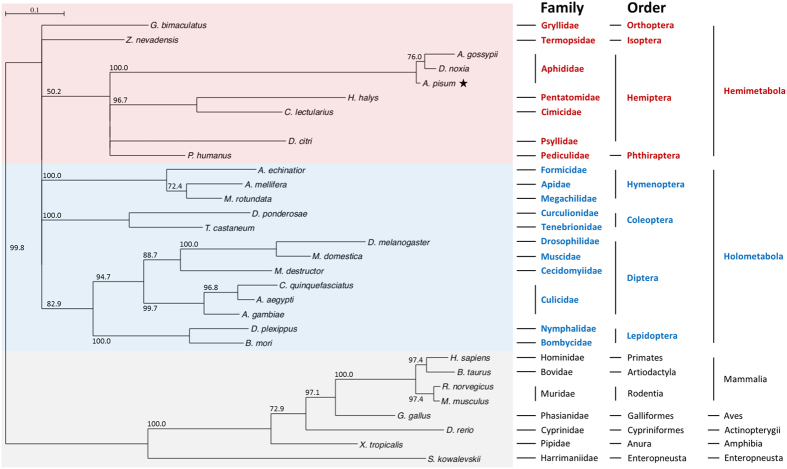
Unrooted phylogenetic tree of PAH proteins.Maximum-likelihood phylogenetic tree reconstruction was performed using the SeaView software53, according to a PhyML method54 with an LG 4-rate class model. Branch-support values were calculated by the bootstrap method with 1000 replications, and displayed at each inner node. Branches with bootstrap values below 50% were collapsed. Insect orders were positioned according to the insect phylogeny determined by Misof et al.58. The sequences (with GenPept accession numbers) used for the phylogenetic analysis are listed in Supplementary Table S1.